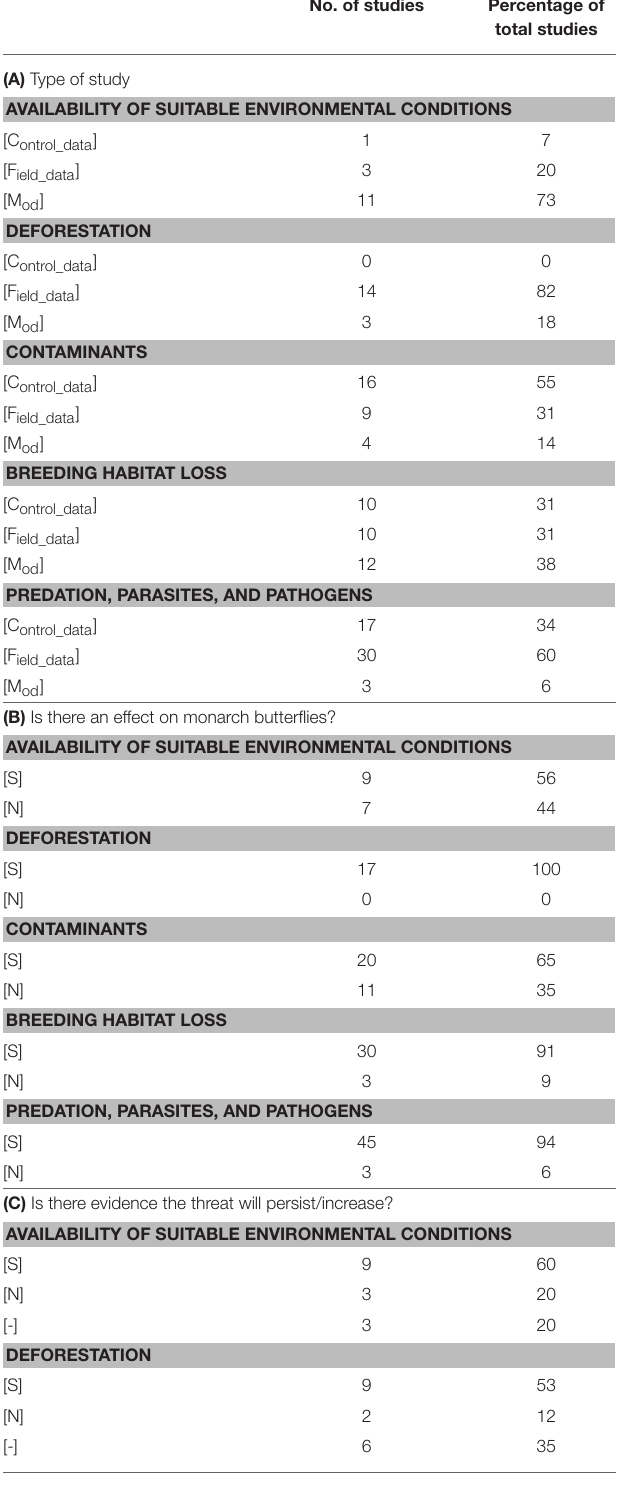
TABLE 2 | The proportion of peer-reviewed research papers classified by the type of study, effect on monarchs, and potential risk imposed by the threat to the eastern migratory North American population of monarch butterflies ( Danaus plexippus